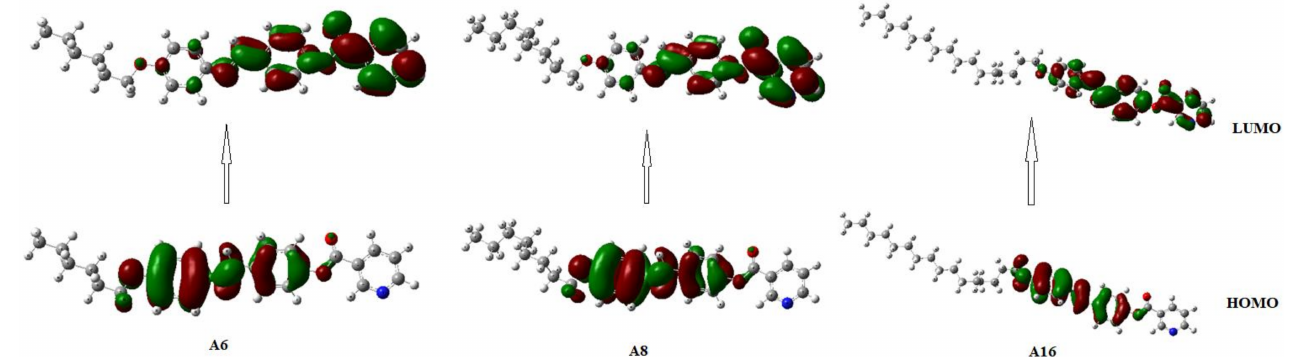
Figure 5. Estimated geometry for frontier molecular orbitals (FMOs) of the investigated homolog, An